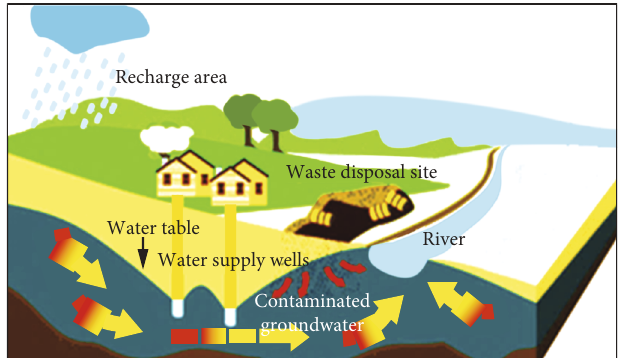
Figure 1: Schematic diagram illustrating groundwater contamination from a waste site (source: Environment Canada, researchgate.net, accessed November 4,